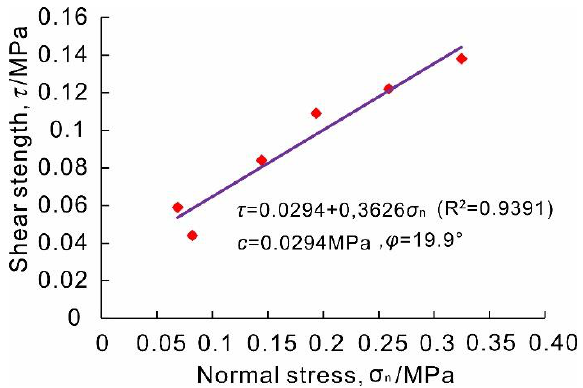
Figure 9. Shear strength of the slip zone soil of the Riverside Slump I# of the Huangtupo landslide obtained by in situ shear tests.